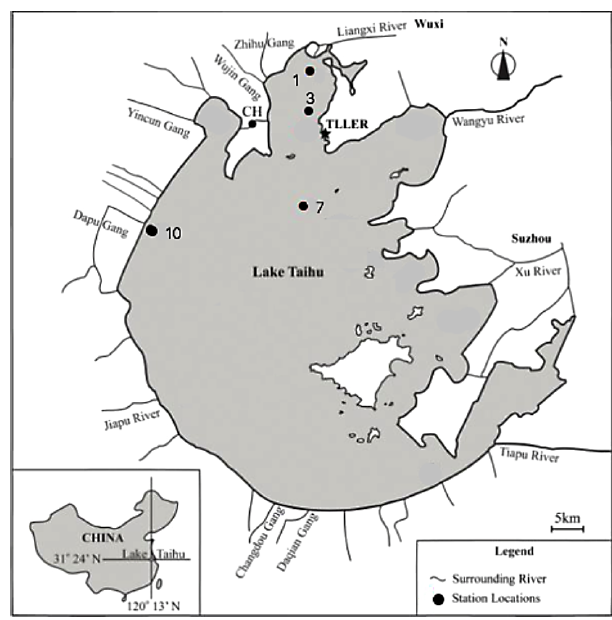
Figure 1. Map of sampling stations in Taihu Lake (modified from Paerl et al.,